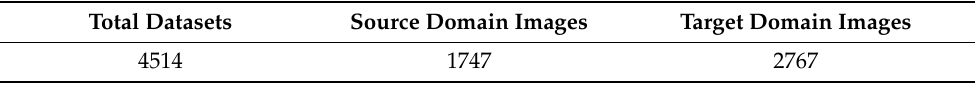
Table 2. Dataset composition of style transfer